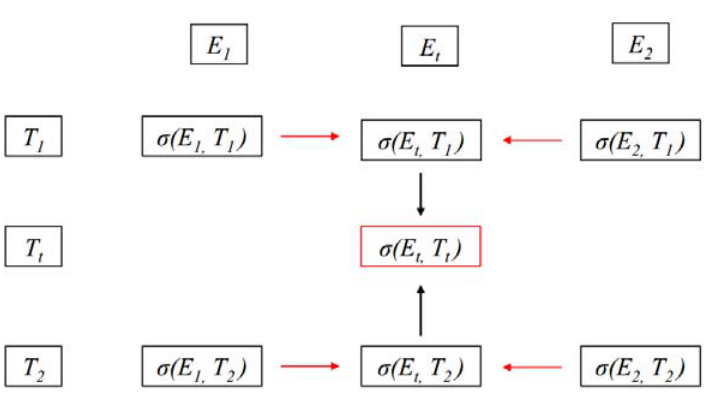
Figure 1. Two - dimensional linear - linear interpolation for the inelastic scattering cross